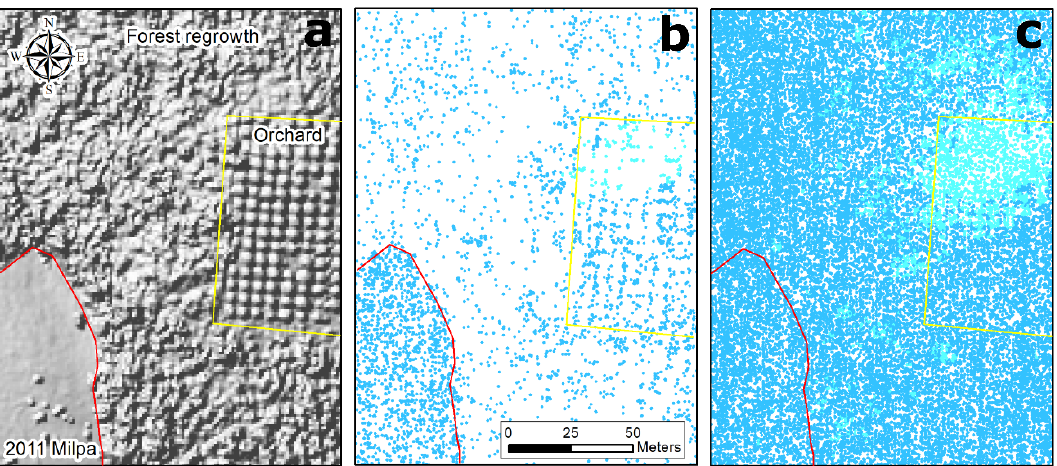
Figure 13. ( a ) Vegetation types, 2011 milpas , orchards, and areas of forest regrowth are visible on the lidar DSM and impact the lidar point cloud. ( b ) Ground points are randomly dispersed in the forest regrowth area and show the outline of orchard trees resulting in large patches, with few points, especially when compared to ( c ) the total point cloud coverage, creating challenges for archaeological prospection of small features. The ground points of the 2011 milpa are higher than the surrounding landscape, thus facilitating archaeological prospection.